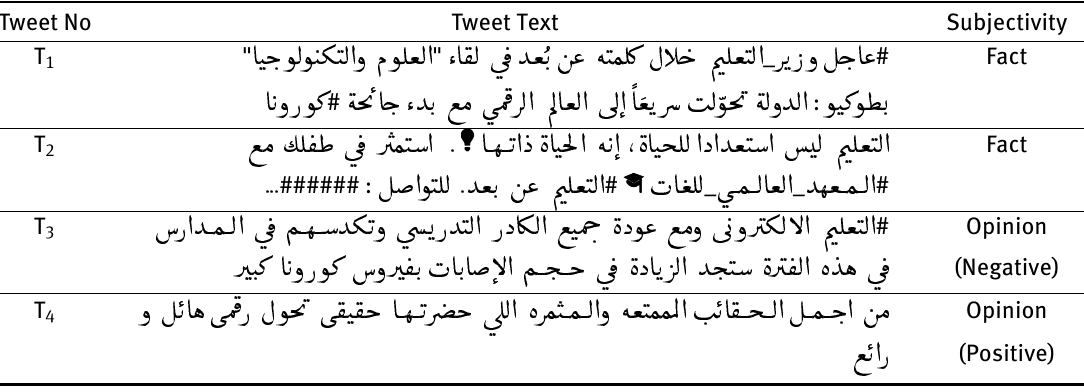
Table 2: Some instances for facts and opinions Tweet